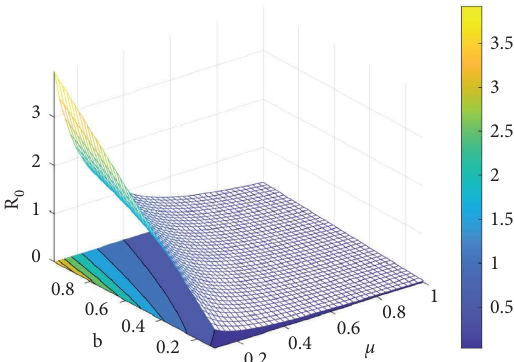
Figure 5: Te dynamics of sensitivity analysis with respect to parameters μ and b with R with 0 . 0